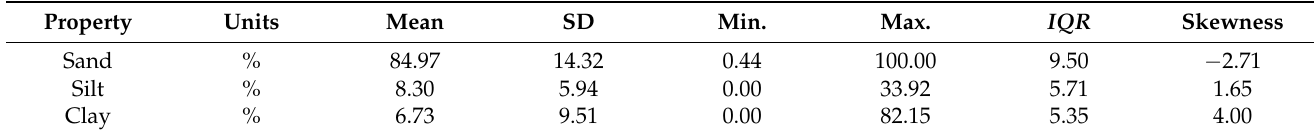
Table A1. Descriptive statistics of properties in the “Texture” group.